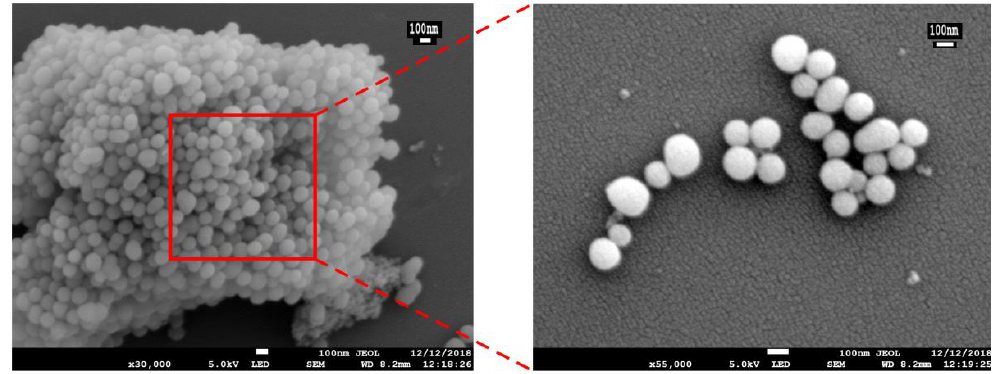
Figure 2. SEM images of mesoporous silica nanoparticles (MSN).